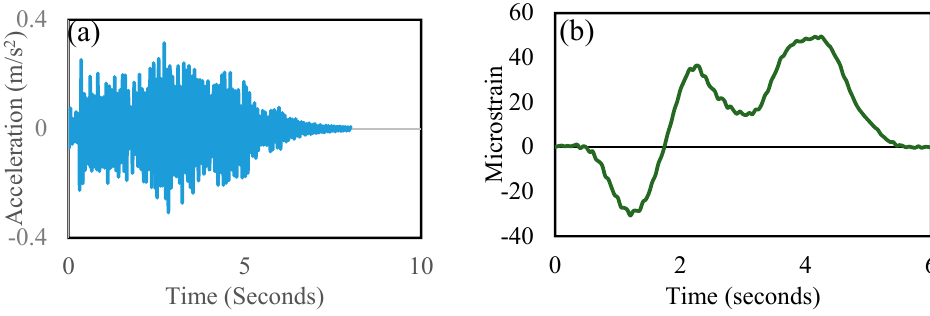
Figure 5. Operational response from the undamaged bridge: ( a ) acceleration from vertical sensor V1 at node 1, ( b ) strain from truss element 32.